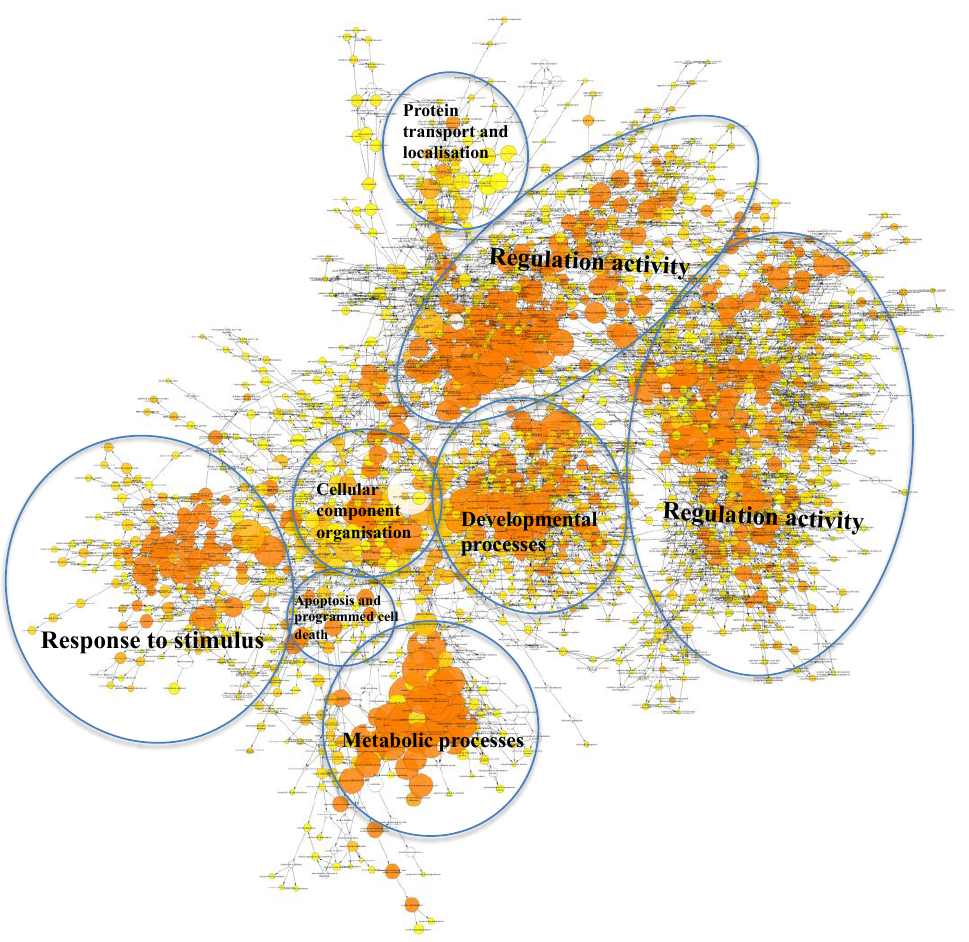
Figure 3. Visualisation of the biological processes (BPs) resulting from the analysis of target genes regulated by hsa-miR-205 associated with HaCaT-derived EVs using Cytoscape (Version 3.2.1).